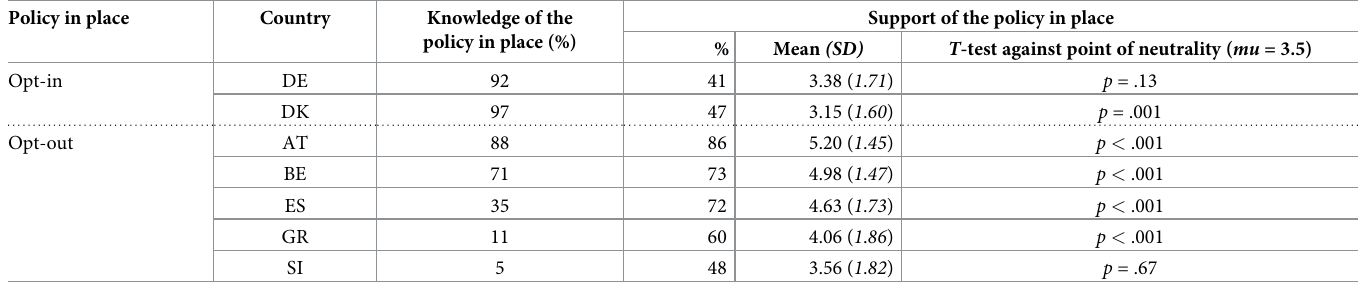
Table 4. Knowledge and support rates by consent policy and